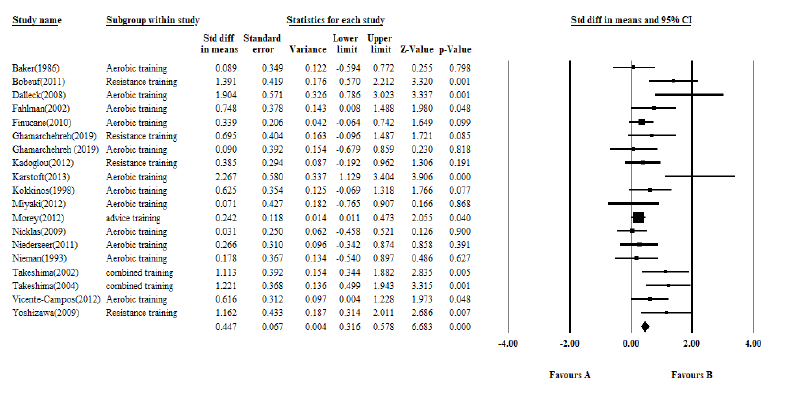
Figure 2. Effects of training on HDL (mg/dL), forest plot showing pooled mean differences with 95% CI for 19 effect sizes obtained from 20 trials (two distinct effect sizes for various modalities were prepared by Ghamarchehreh et al) (30) .